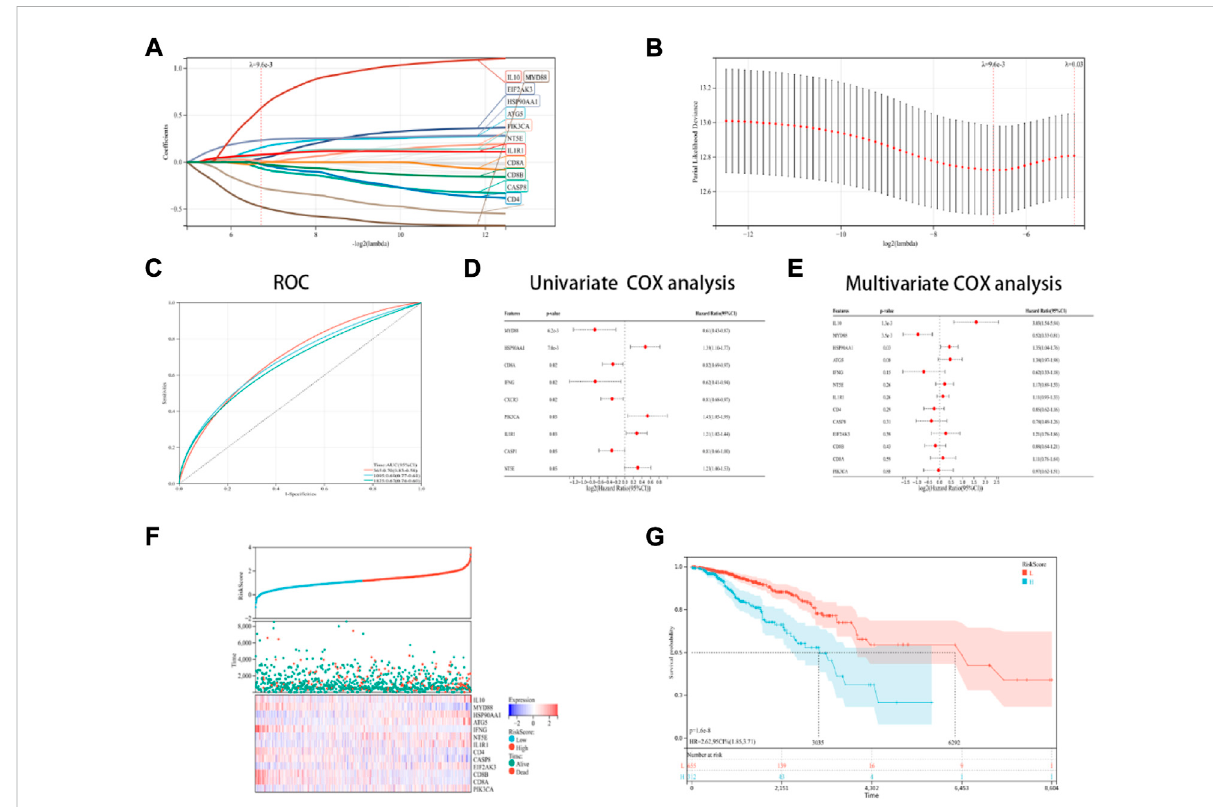
FIGURE 5 Designing and validating the ICD risk signature. (A,B) Lasso Cox regression analysis was used to identify 13 genes in the TCGA dataset that were strongly associated with OS; (C) ROC curves with the AUC values; (D,E) Univariate and multivariate Cox regression analyses were performed for assessing the prognostic values of the ICD genes, with regards to OS; (F) Risk score distribution, OS status of every patient, and the heatmaps depicting theprognosticapplicationofthe13-genesignature; and (G) KMcurves ofthepatient ’ sOS inthehigh-riskcohortandlow-risk cohort